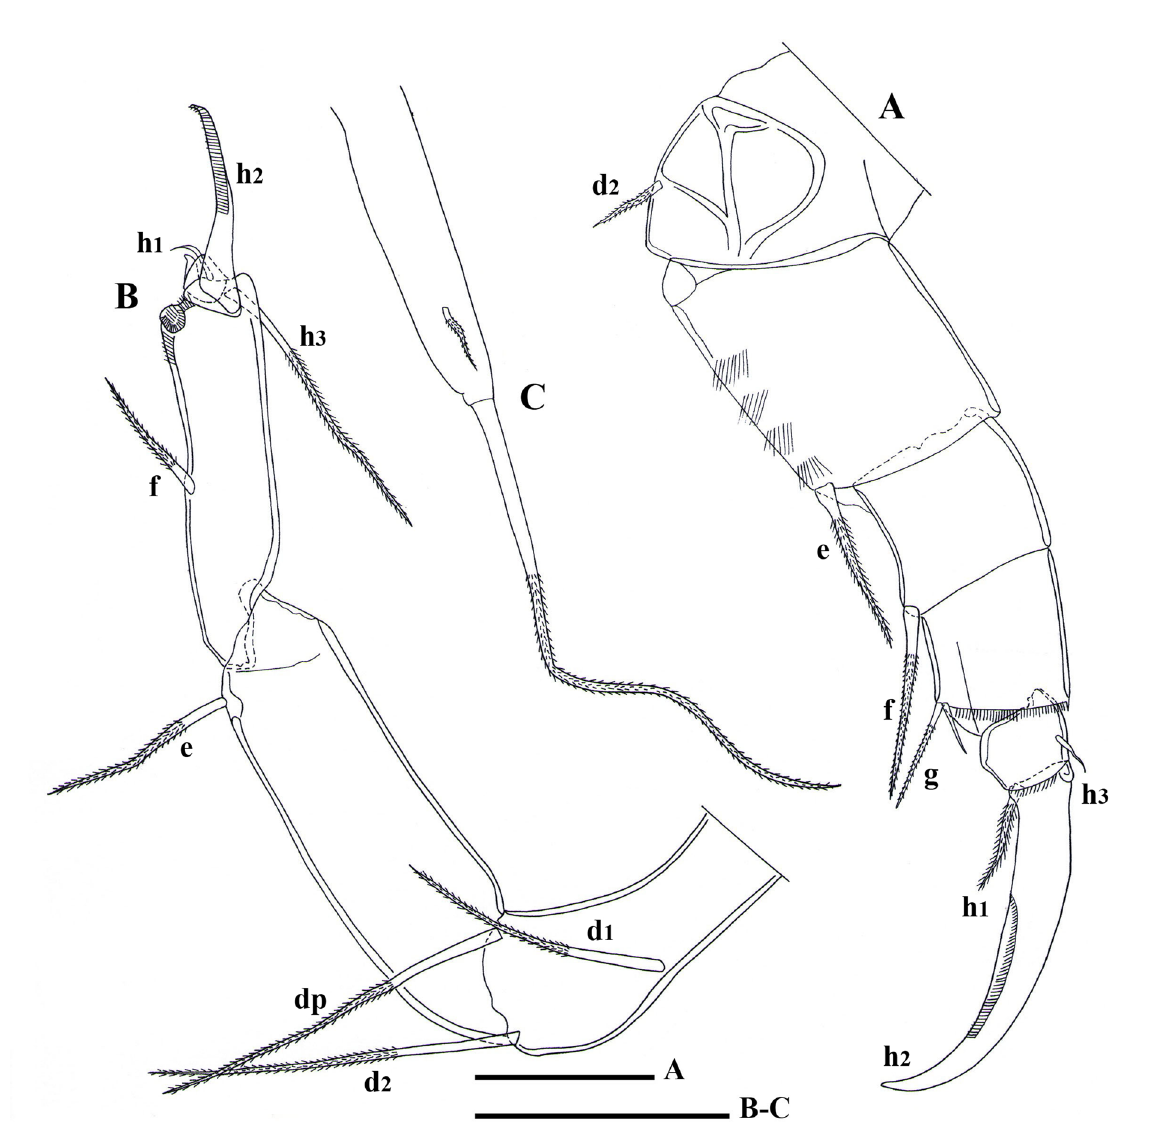
Fig. 18. Siamopsis planitia gen. et sp. nov., ♀ (MSU-ZOC.207). A . T2. B . T3. C . CR. Scale bars: 50